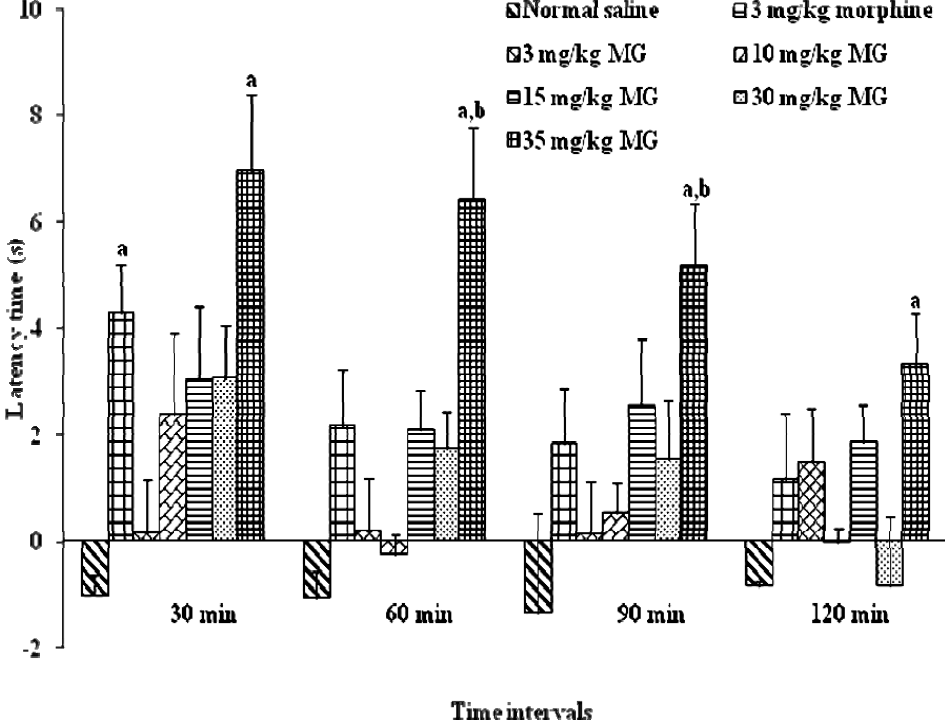
dependent manner. However, the antinociceptive effect of MG was marginally reduced at 40 mg/kg and 60 mg/kg (data not shown). Figure 4. The effects of mitragynine (3 mg/kg, 10 mg/kg, 15 mg/kg, 30 mg/kg and 35 mg/kg), morphine and control on latency time in hot-plate test (HPT) for various time intervals. Mitragynine was administered 15 min before the HPT intraperitoneally (i.p). Each column represents the mean ± SEM of latency time (s) for group of eight animals in each group. Values are statistically significant at p < 0.05. a 35 mg/kg b.wt of MG treated groups were compared to normal saline (vehicle control) group; b 35 mg/kg b.wt of MG treated groups were compared to 3 mg/kg b.wt morphine group.